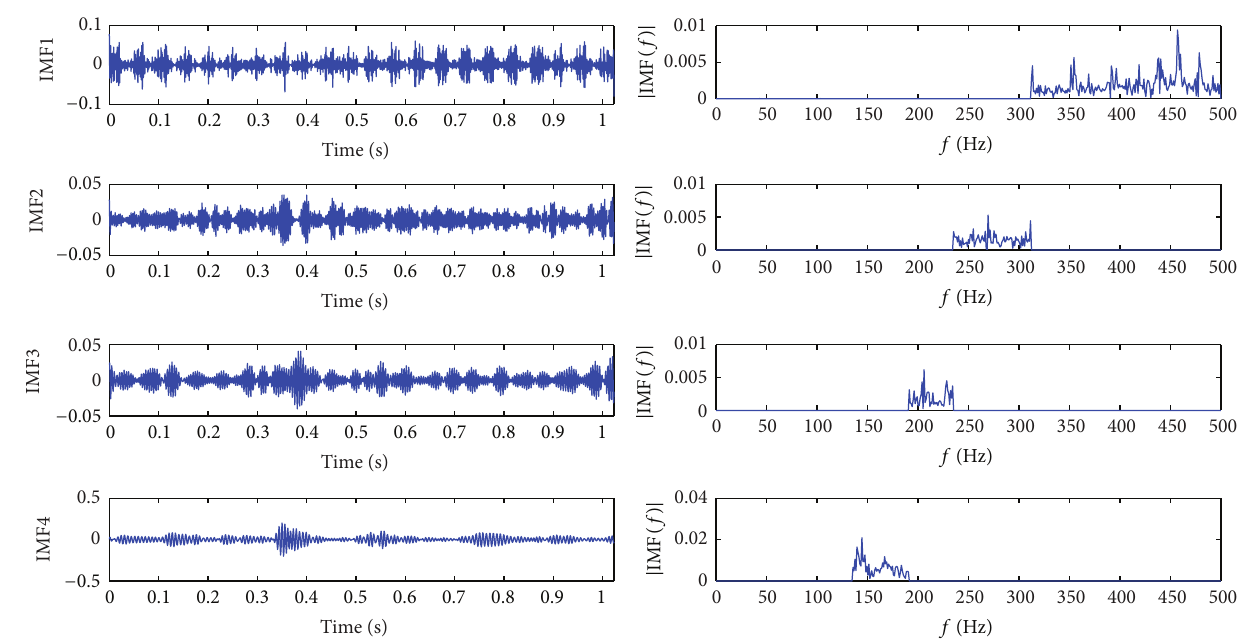
Figure 7: IMF1–4 obtained after OEMD